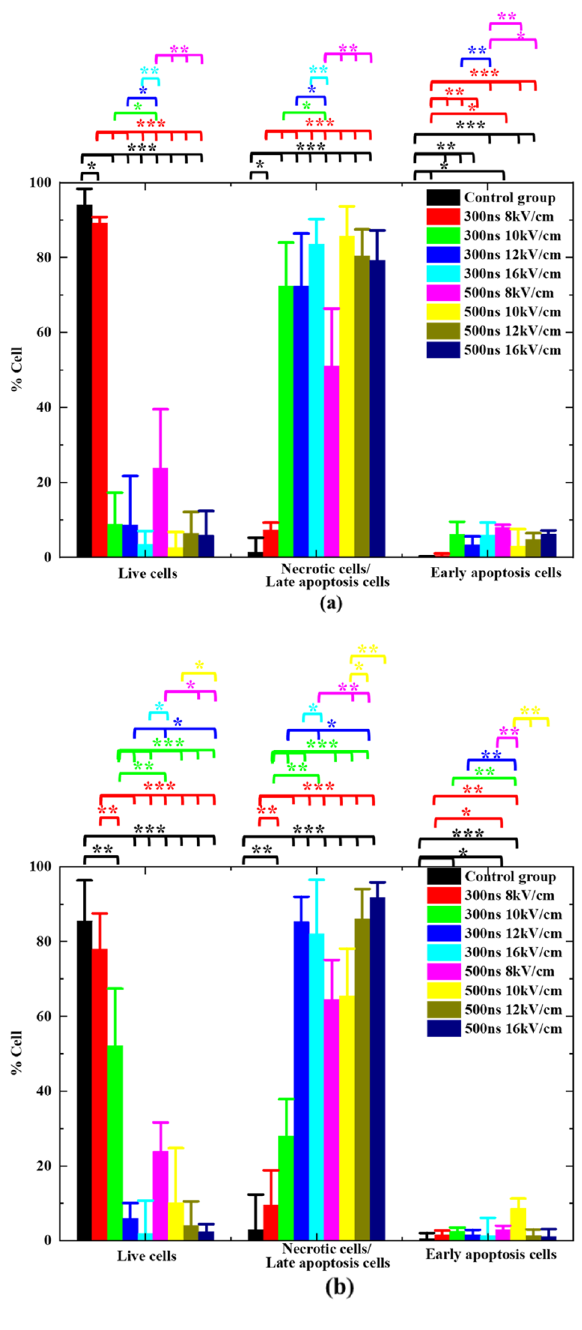
Figure 5. Proportions of ( a ) B16 and ( b ) L929 cells in different statuses of the cells exposed to nsPEF with different parameters and incubated for 15 min before being assayed(* P < 0.05; ** P < 0.01; *** P <